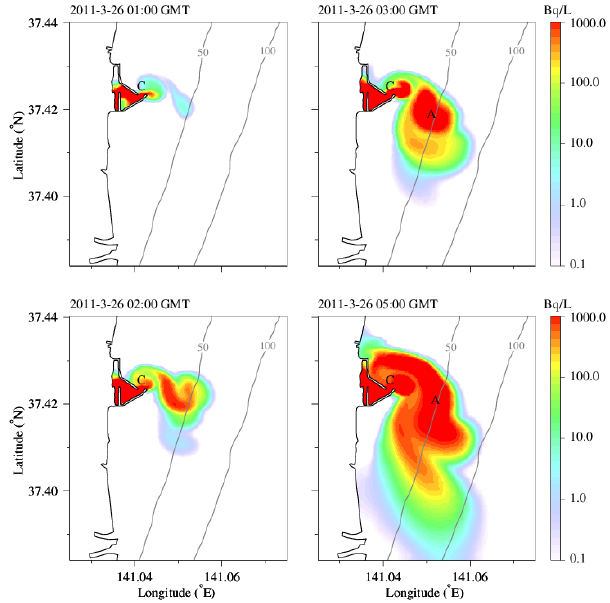
Fig. 11. Distributions of the high-resolution nested model computed surface 137 Cs concentration around FNPP at 01:00, 02:00, 03:00 and 04:00GMT, 26 March 2011. Label “C” indicates the location of a cyclonic vortex, and label “A” indicates the location of an anti- cyclonic